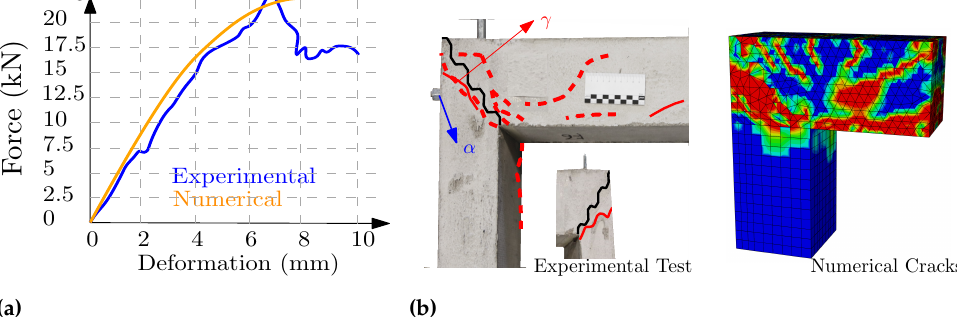
Figure 10. F3, ( a ) Force–deformation, ( b ) experimental cracking and numerical cracking